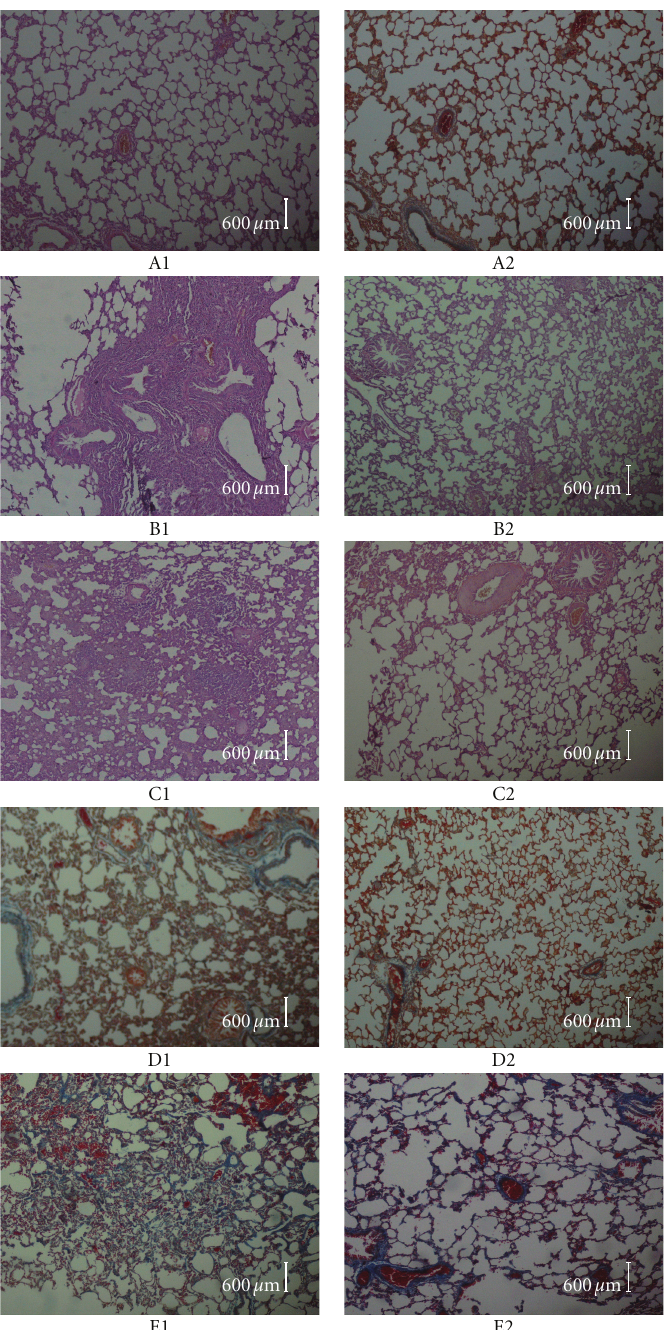
Figure 2: The left lung histological slices of SD rats from groups of the control, PQ treatment, and PQ+PDTC treatment. In A1 (light micrographs of lung sections stained with hematoxylin and eosin (HE) from control), evidencing a normal pulmonary structure without evidence of alveolar collapse, vascular congestion, or cellular infiltrations. In B1(PQ group on the 3rd day HE), the capillary vessel of alveolar wall dilation, congestion in lungs, hemorrhagic lung, and alveolar epithelium detached, edema, and infiltration of inflammatory cell around bronchia can be visible. In B2 (PQ+PDTC group on the 3rd day HE), a slight decrease in the alveolar space can be observed as well as the existence of several infiltrative vacuolated cells in the interstitial and in the alveolar space. In C1 (PQ group on the 7th day HE), the lungs showed an accumulation of mixed inflammatory cells in the alveolar region and confluent areas of marked interstitial thickening. In C2 (PQ+PDTC group on the 7th day HE), there was a slight change. In A2 (MASSON from control group), relatively little collagen accumulation can be observed in control group. In D1 (PQ group on the 14th day MASSON) and E1 (PQ group on the 21st day MASSON), Masson’s Trichrome staining showed collagen accumulation, broadened alveolar wall and patchy collagen deposition within the expanded interstitium in some areas. In D2 (PQ+PDTC group on the 14th day MASSON) and E2 (PQ+PDTC group on the 21st day MASSON), a slight collagen accumulation can be